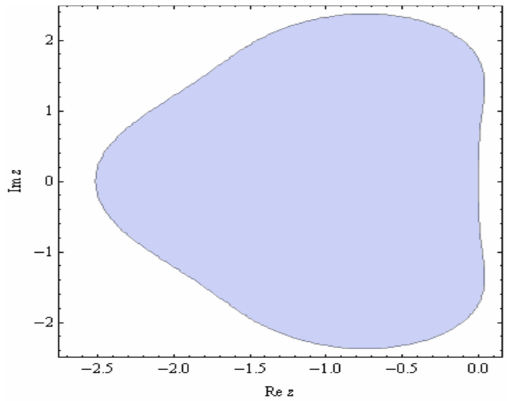
Figure 1. Stability region of the proposed scheme.